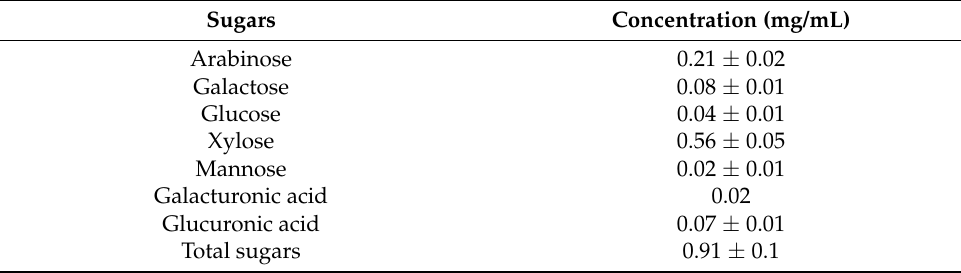
Figure 4. Appearance of coir fibers. The average length of coir fibers is about 15 mm. Table 1. Physical and chemical properties of coir fiber.